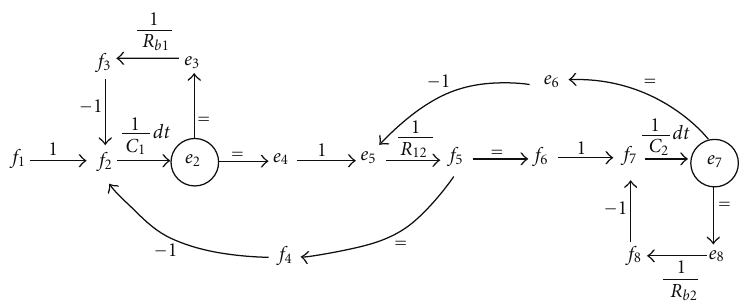
Figure 5: Temporal causal graph of a bitank